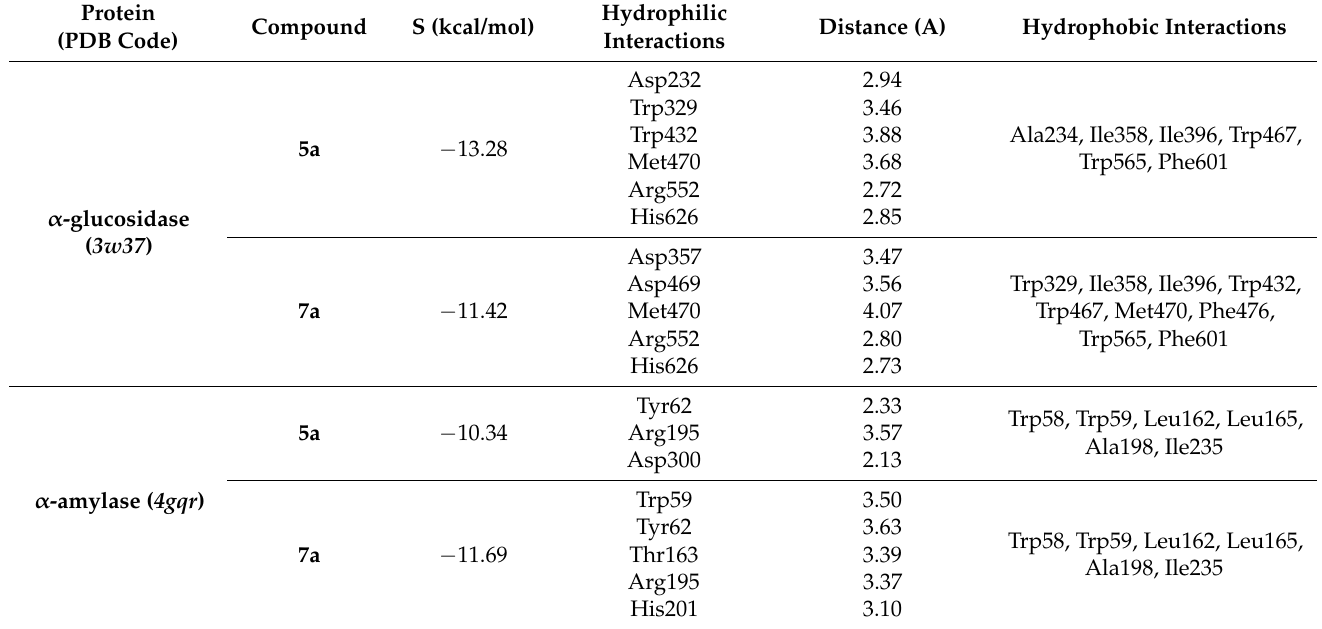
Table 1. Binding energies and predicted interactions of conformers of compounds 5a and 7a toward the pocket of α -glucosidase (PDB: 3w37 ) and α -amylase (PDB: 4gqr )